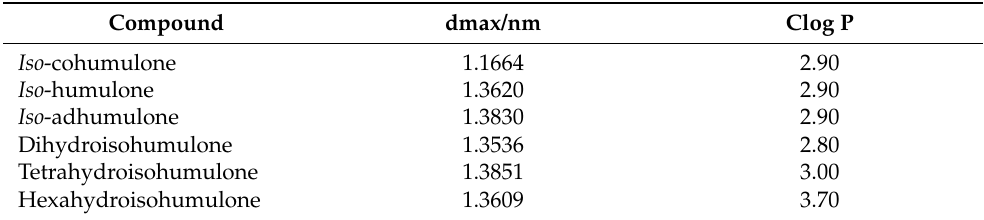
Table 1. To predict the transport of molecules across cells membranes it is necessary to know their maximum calculated diameter (dmax/nm) and they calculated partition coefficient (ClogP). Blanco et al. demonstrated that isomerized H. lupulus compounds have a molecular length not exceeding 1.5 nm indicating a great ability to spread through the cell membrane. Further, it was demonstrated that isomerized α -acids and their reduced derivatives have a good grade of lipophilia, as indicated by their ClogP value [19]. Compound dmax/nm Clog P Iso